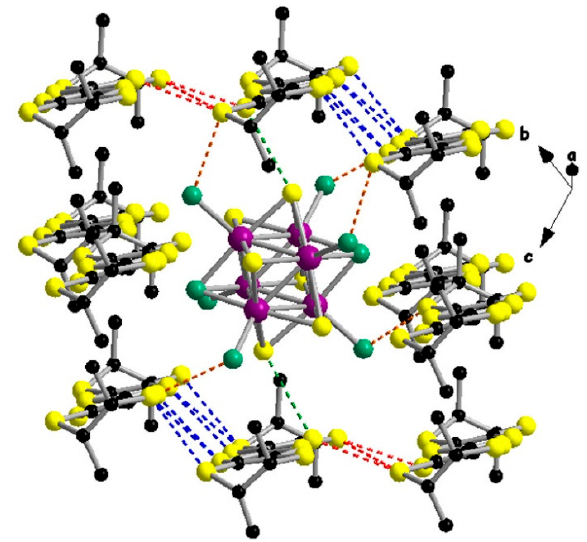
Figure 3. Re cluster encapsulated in a “cage” of donors. Short intermolecular contacts: S TTF ···S TTF 3.21–3.35 Å ( red ) and 3.59–3.67 Å ( blue ), S TTF ···S cluster 3.44–3.58 Å ( green ) and S TTF ···Cl 3.38–3.72 Å ( orange ).